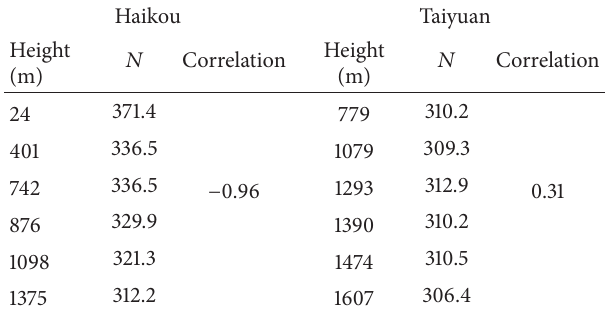
Table 5: Correlation coefficients of the refractivity ( 𝑁 ) with height. Table 6: Relative error in the electromagnetic wave propagation path during the airplane’s